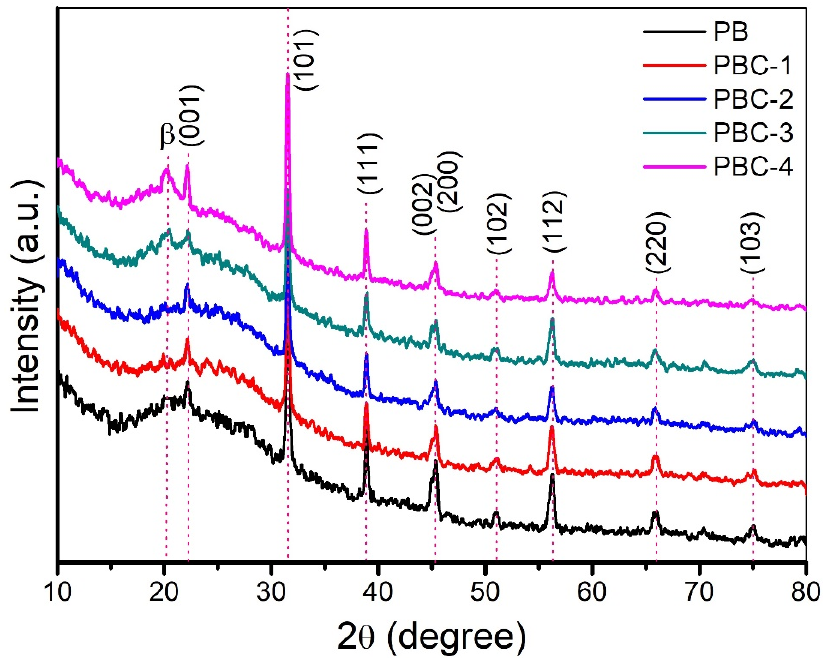
Figure 4. Representative XRD patterns of the as-prepared PVDF–BaTiO 3 (PB) and PVDF–BaTiO 3 - x CNT (PBC) films.